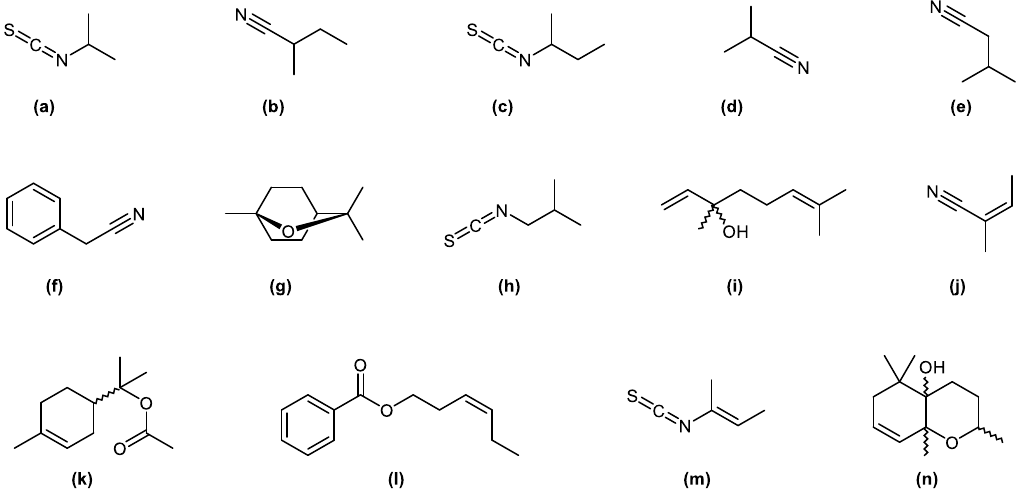
Figure 1. Chemical structure of some of the characteristic constituents from the leaf essential oil of CC.